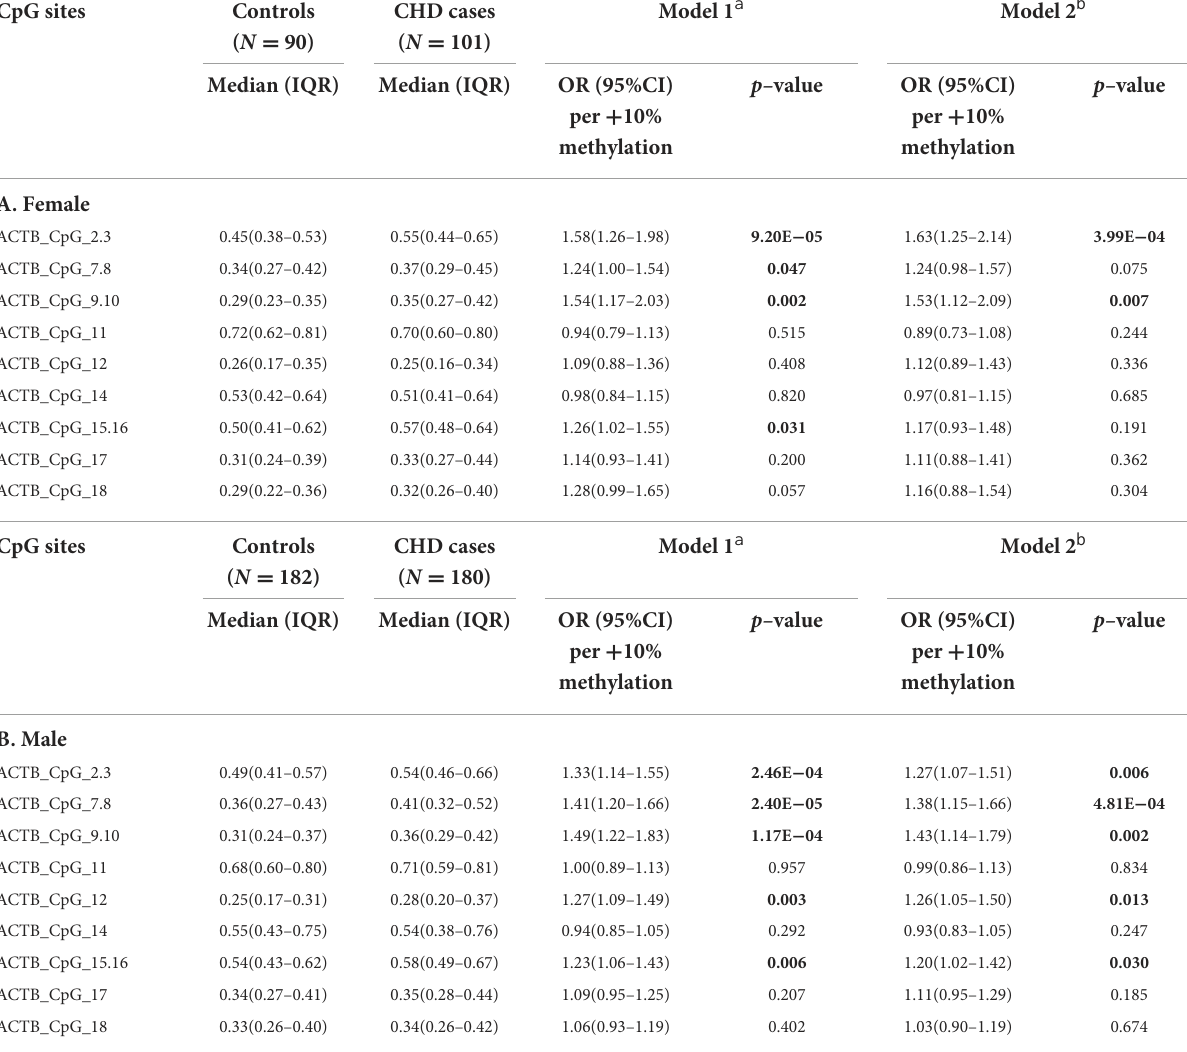
TABLE 3 Gender–specific methylation difference of ACTB between CHD cases and